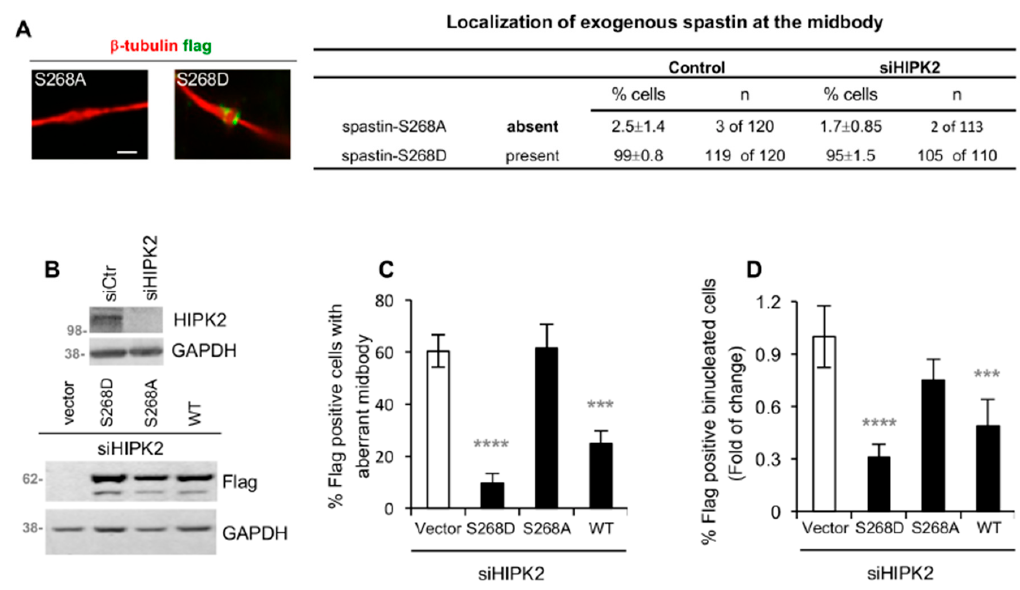
Figure 5. Spastin-S268D restores abscission in siHIPK2 cells. ( A ) HeLa control cells and siHIPK2 cells were transfected with vectors expressing flag-myc-tagged spastin-S268A or -S268D and analyzed 48 h post transfection by IF after staining with DAPI, anti- β -tubulin, and anti-flag Ab to visualize midbody localization of exogenous spastin. Representative immunostainings of midbody magnification are shown in the left panels. Bar, 1 µ M. Data quantification are reported, the values are mean ± SEM from three independent experiments. Similar data were obtained by using anti-myc Ab to stain exogenous spastin (data not shown). ( B – D ) siHIPK2 cells were transfected with flag-myc empty vector or indicated flag-myc spastin-expressing vectors 48 h post siRNA transfection performed as in Figure 1A and analyzed 48 h post vector transfection by WB and IF after staining with anti-Flag, anti- β -tubulin, and DAPI. In ( B ), representative WB are shown. In ( C ), the percentage of Flag-positive cells, showing aberrant midbodies, is reported as mean ± SEM from three independent experiments, each performed in duplicate, in which at least a total of 80 midbodies per condition were analyzed. In ( D ), the percentage of Flag-positive binucleated cells is reported as fold-change relative to that of vector-transfected cells in two independent experiments, in which total > 2000 cells were scored. The percentages of Flag-positive binucleated cells (mean ± SEM) are the following: 4 ± 0.5, 1.95 ± 0.55, 3 ± 0.30, 1.25 ± 0.25 for siHIPK2 cells expressing empty Vector, spastin-WT, -S268D, and -S268A, respectively. **** p < 0.0001, *** p < 0.001( p = 0.0002) χ 2 test.